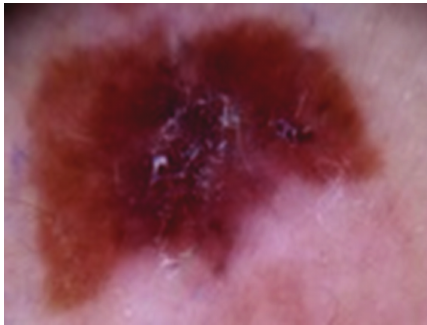
Figure 4: Case 2. H&E shows pBD with marked hyperkeratosis, parakeratosis and acanthosis consisting of atypical keratinocytes on all levels of the epidermis. Dilated capillary vessels and grouped melanophages can be seen in the papillary dermis.